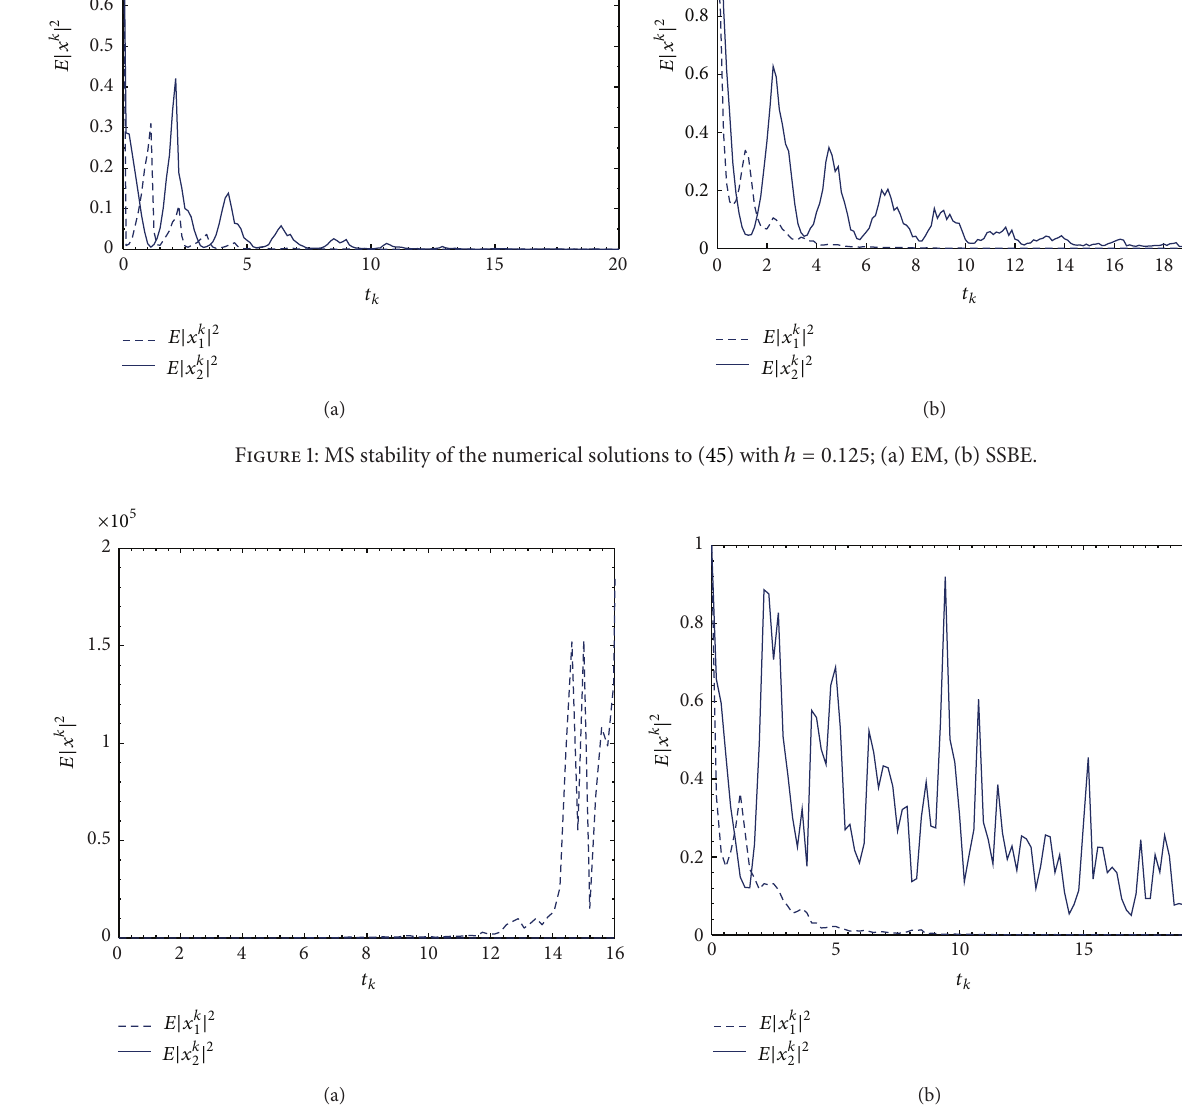
Figure 2: Instability of EM numerical solutions and MS stability of SSBE numerical solutions to (45) with ℎ = 0.1925 ; (a) EM, (b)